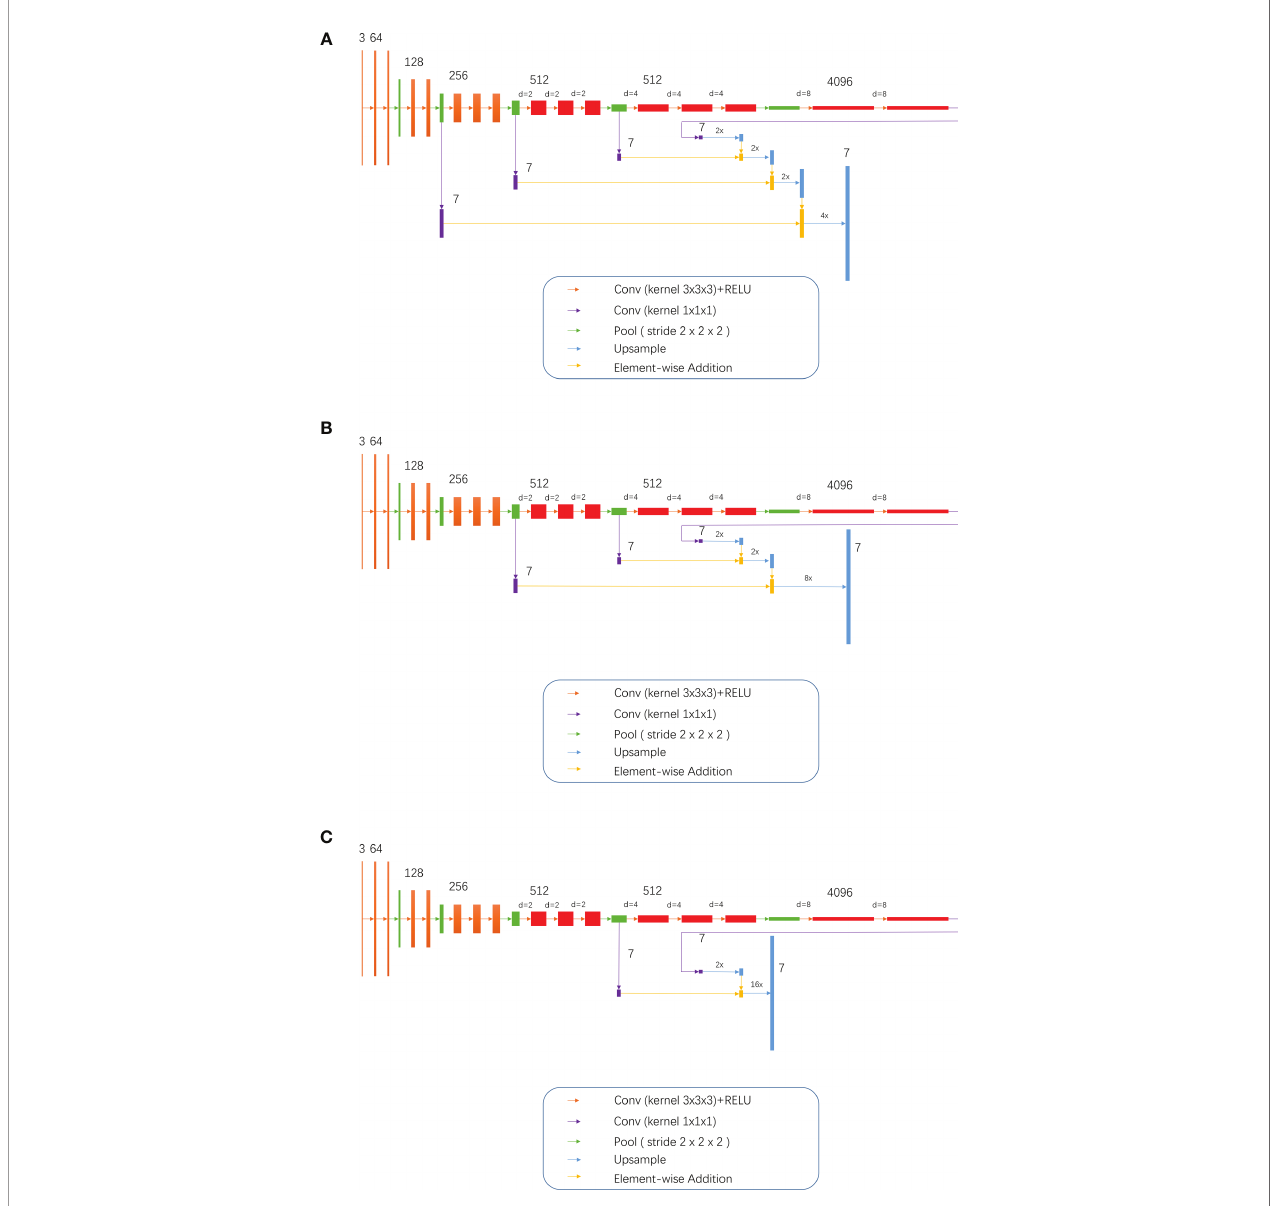
FIGURE 2 | 3, 7, 64, 128, 512 and 4096 meant 3 7, 64, 128, 512 and 4096 image channels, respectively; d meant d-1 dilation were plug in between every two elements of the convolution kernel; 2x and 4x are multiples of upsampling. (A) D-FCN 4S; (B) D-FCN 8S; (C) D-FCN